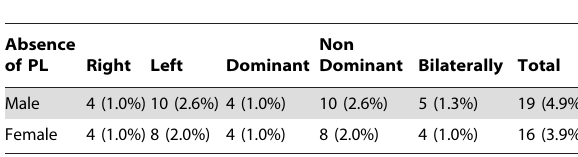
Table showing the distribution of the absence of the Palmaris longus between males and females and according to the hand